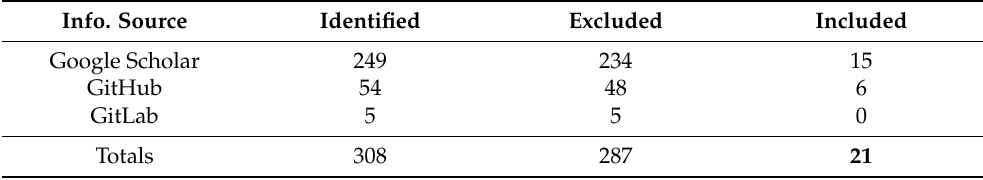
Table 3. Number of works identified with the search strings for each information source, as well as number of works excluded and included after the filtering criteria has been applied. Value in bold corresponds to the number of works selected for this